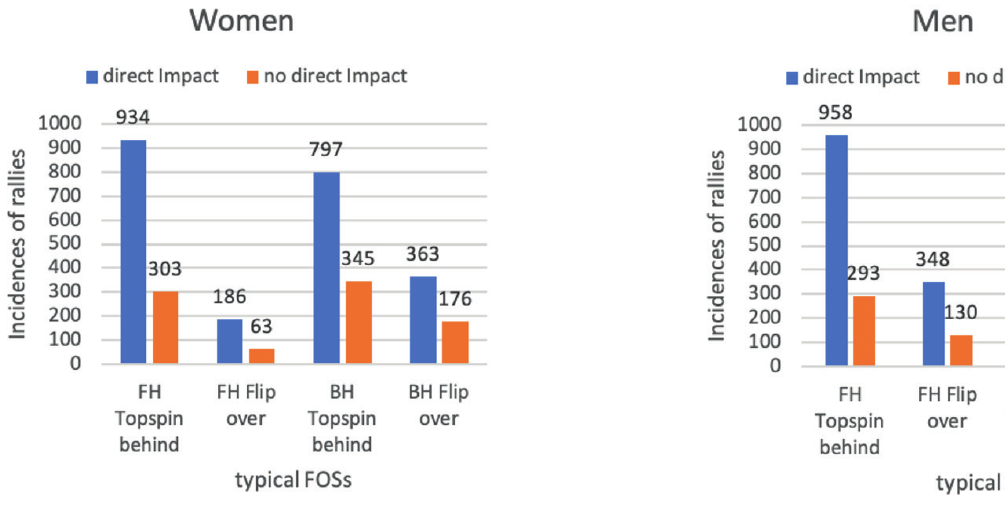
Figure 9. Incidences of typical FOSs separated by impact of FOS for men.